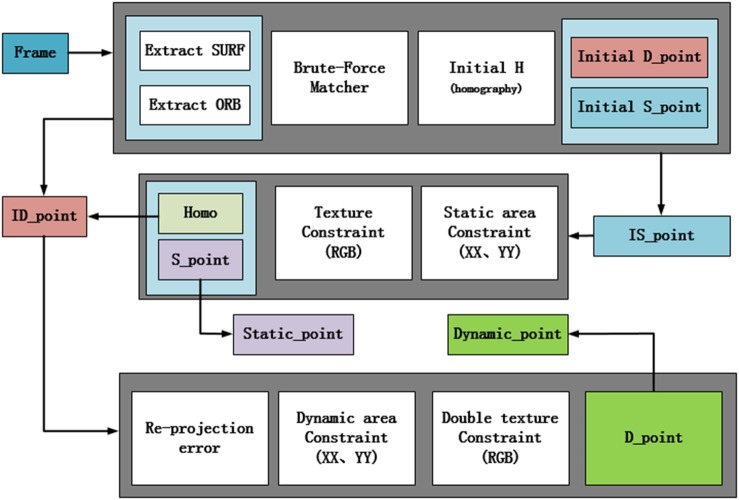
System structure.